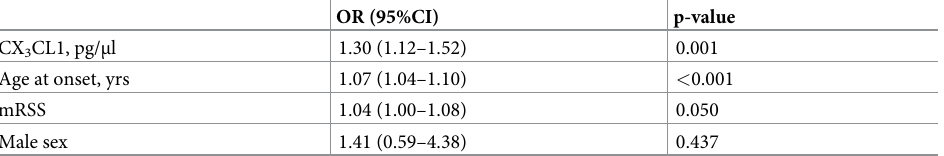
Table 4. Multivariable logistic regression analyses with the primary composite ILD endpoint including FVC decline � 5%, or DLCO decline � 7.5%, or death within 12 months in the Oslo University Hospital SSc cohort.